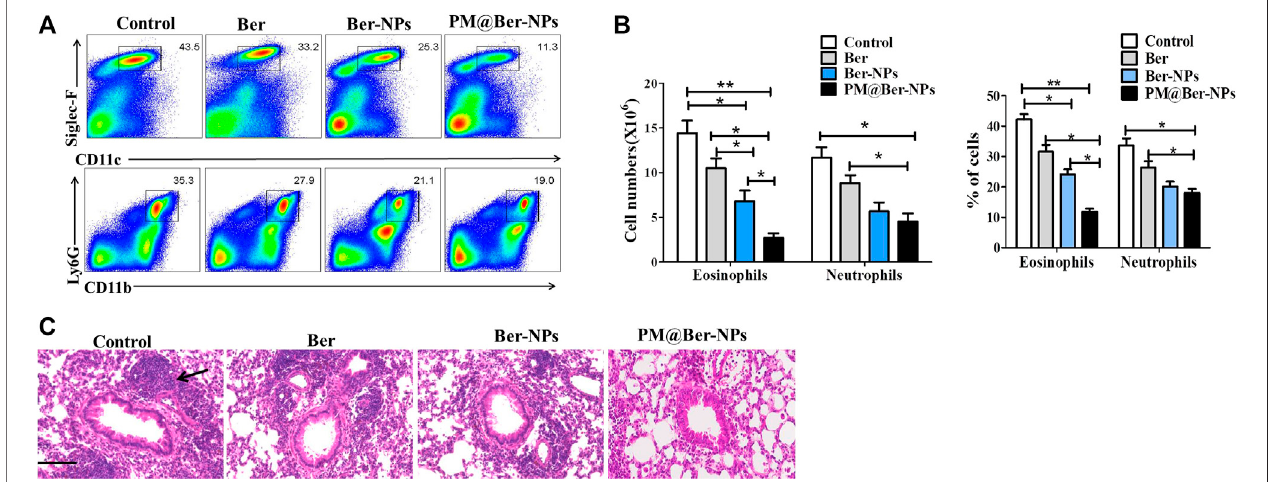
FIGURE4| Ber-loadedbiomimeticNPsalleviatelungin fl ammationofasthmaticmice. (A) In fi ltratedcellsinthelungwithHDM-inducedasthma( n (cid:1) 5)wereisolated and followed by fl ow cytometry analysis. (B) The cell numbers and percent of different in fi ltrated cells were calculated for each mouse. (C) Hematoxylin and eosin (H&E) staining of a lung section from mice with HDM-induced asthma. Arrow shows in fi ltrated cells from blood vessels accumulated around mice ’ s lung airway. Scale bars, 100 μ m. * p < 0.05; ** p < 0.01.